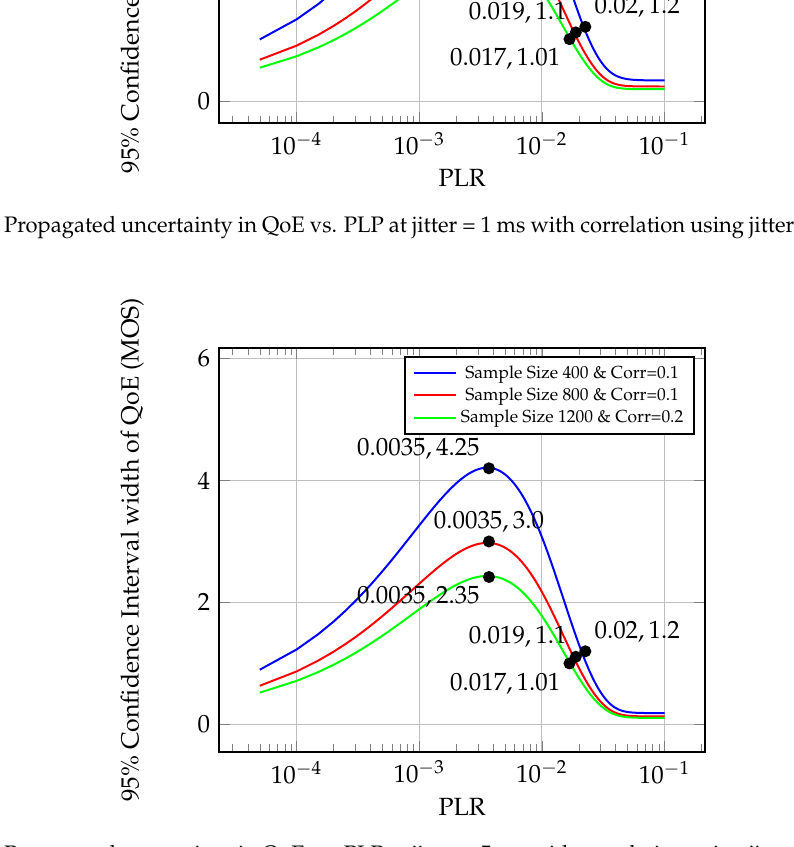
Figure 5. Propagated uncertainty in QoE vs. PLP at jitter = 5 ms with correlation using jitter model